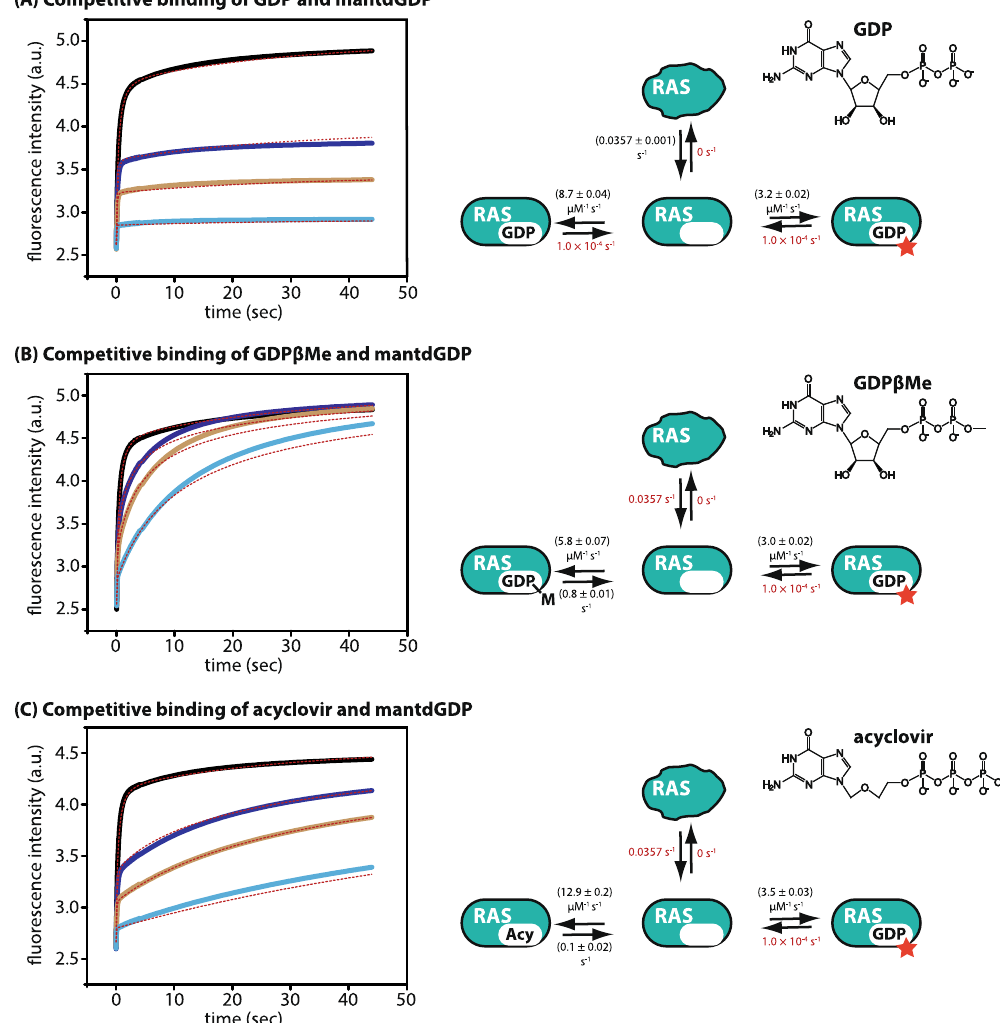
Figure 1. Interaction of KRas with different nucleotides. In order to quantify the interaction of nucleotide- free KRas, competitive binding experiments between mantdGDP and GDP ( A ), GDP β Me ( B ) and acyclovir triphosphate ( C ) were performed. In a stopped-flow apparatus, 1 µ M KRas was shot against 1 µ M mantdGDP in the absence (black curve) or in the presence of 0.5 µ M (blue), 1 µ M (orange) or 3 µ M (turquoise) competing nucleotide and the binding curves were globally fit to the model on the right of the diagram to obtain the corresponding binding constants (indicated in black, previously known kinetic constants that were fixed during fitting are indicated in red). In all experiments, a second slow phase was observed that could only be explained by a model in which nucleotide-free KRas is in an equilibrium between a competent (70–80%) and a non-competent (20–30%) nucleotide-binding state, which might arise from partly unfolded protein due to the inherent instability of KRas in the absence of